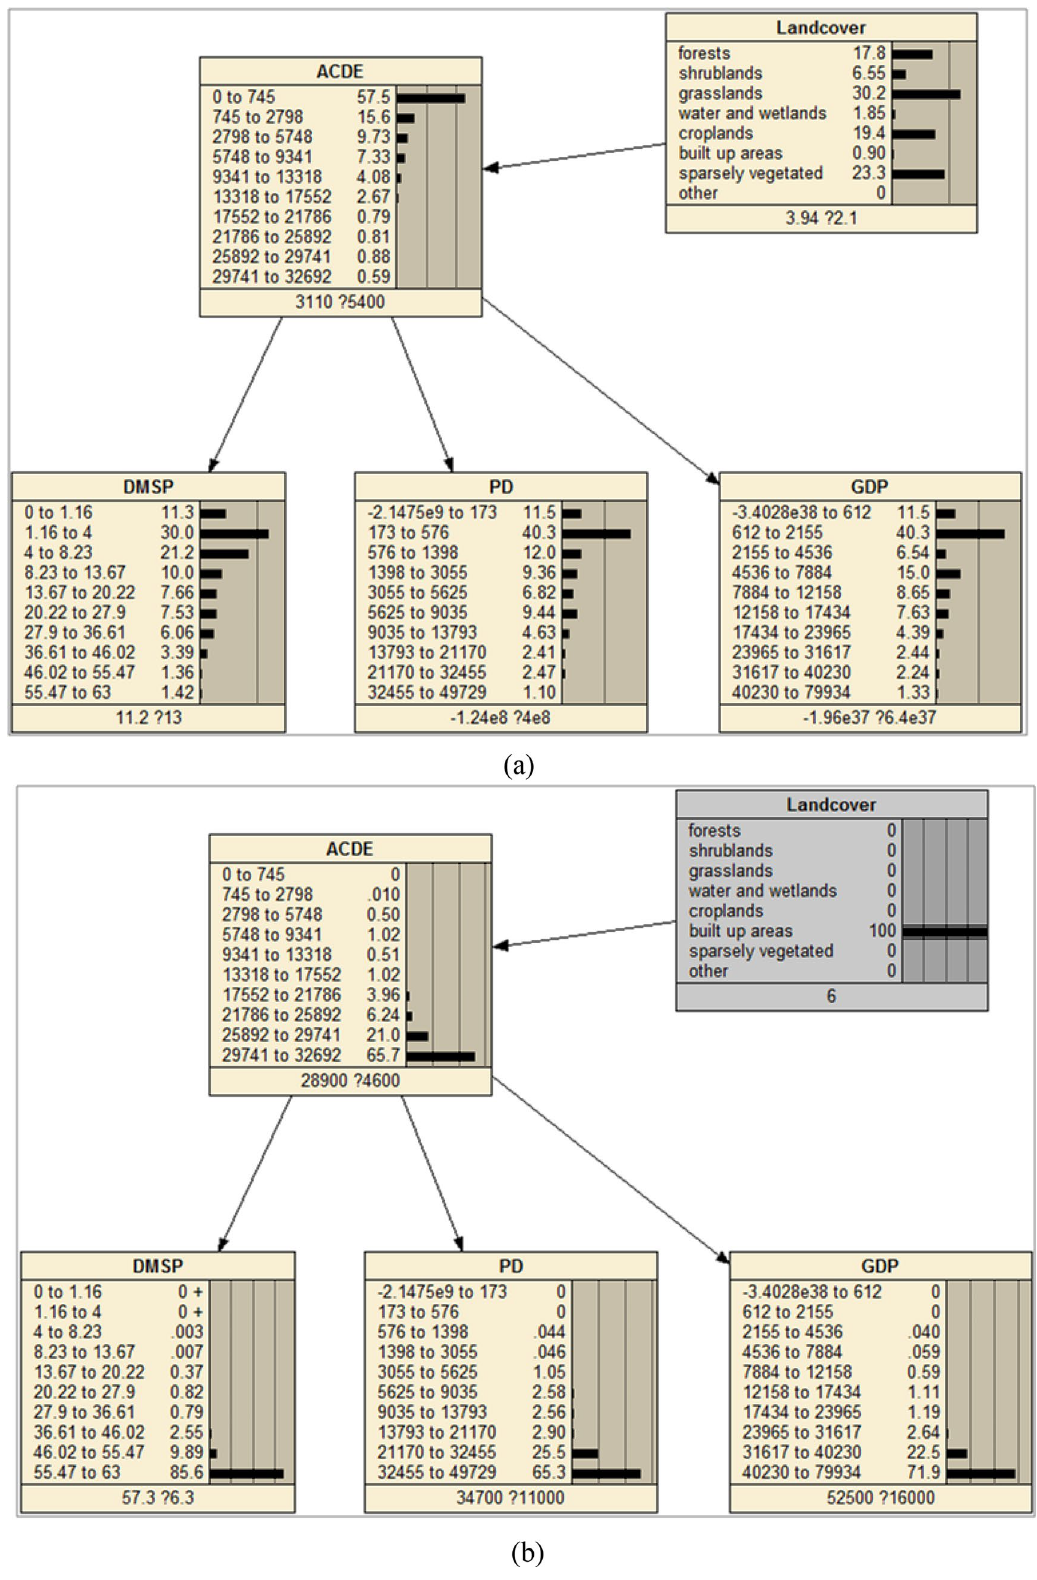
Figure 12. The Naïve Bayesian Network fusing land-cover data as prior knowledge. ( a ) CPTs when adding a land-cover node as the prior knowledge, ( b ) CPTs when give an evidence of land cover. The figs were generated using the Netica software (Norsys Software Corp, Version 5.02, https:// www. norsys.